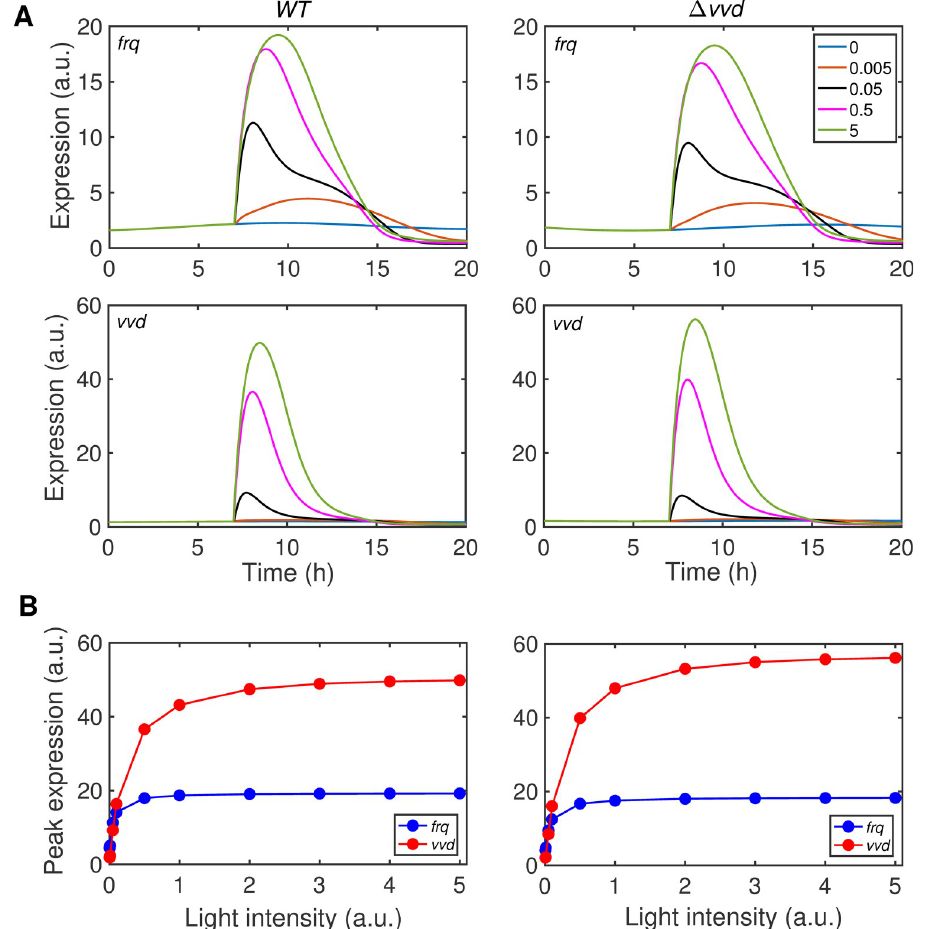
Fig 5. Modelling the response of frq and vvd promoters to light-pulses of different intensity. WT (left panels) and Δ vvd (right panels) were exposed at t = 7 min to a virtual LP. (A) Modeled response of frq and vvd to virtual LPs of the indicated intensities. (B) Plot of peak expression levels of frq and vvd versus LP intensity. Simulated LP intensities: 0; 0.005; 0.005; 0.05; 0.5 and 5.0 arbitrary units